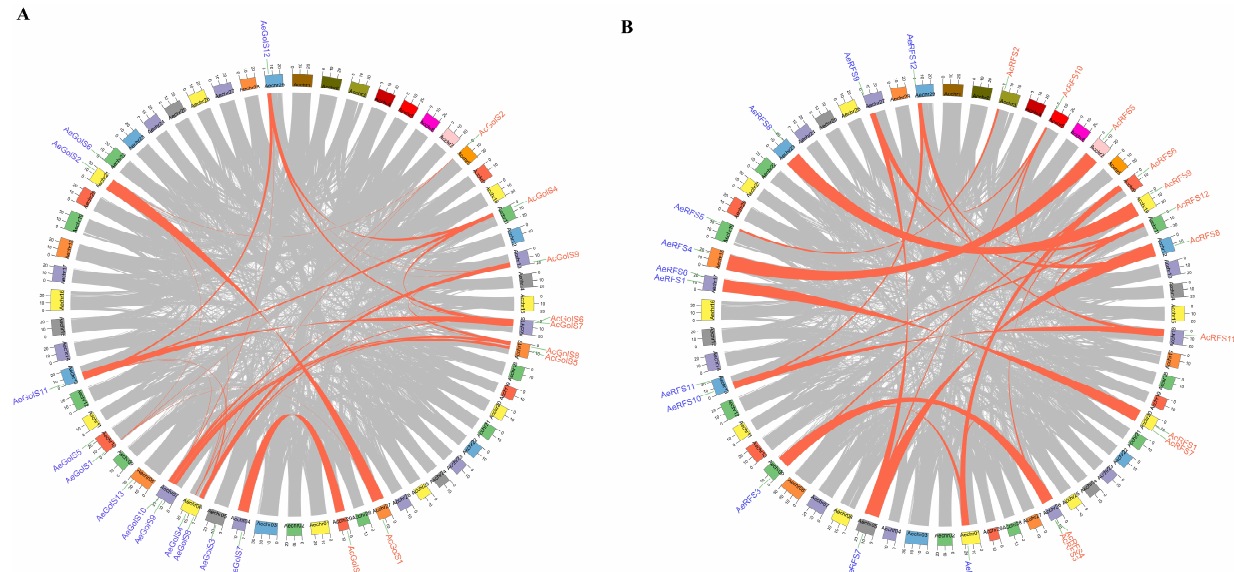
Figure 3. Gene duplication analysis of the kiwifruit GolS and RFS genes. ( A ) Pink lines connect the syntenic regions between the kiwifruit GolS genes. ( B ) Pink lines connect the syntenic regions between the kiwifruit RFS genes.